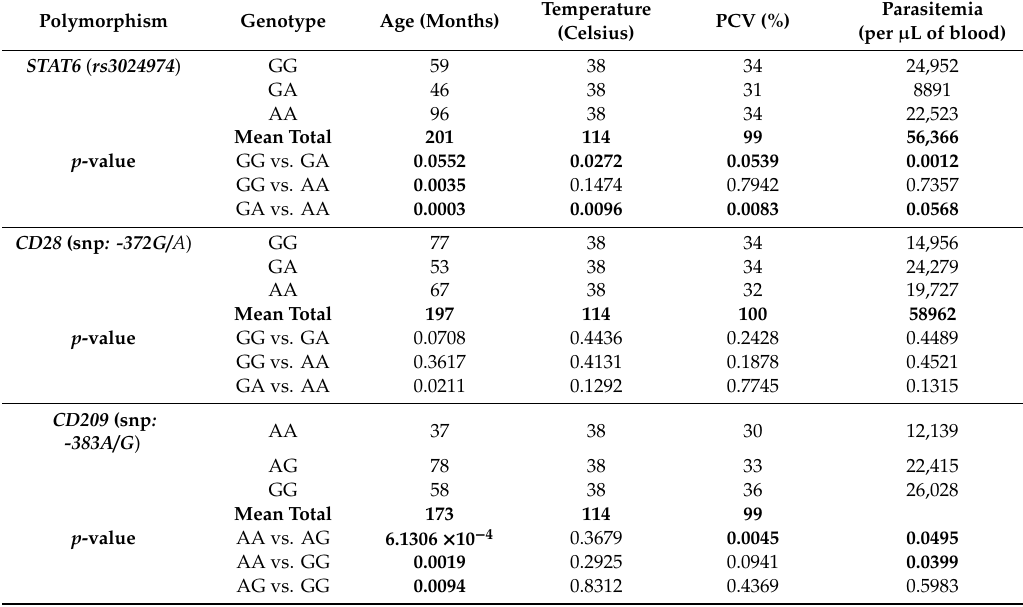
Figure 2. Mean parasitemia among malaria patients with CD209 (snp: -383A > G; rs4804803 ) wild type, heterozygous and mutant variants. Odds ratios were calculated by Fisher’s two-tailed exact tests. A p -value < 0.05 was considered significant. Table 6. Comparative analysis of disease covariates with genetic variants of selected loci among malaria-infected